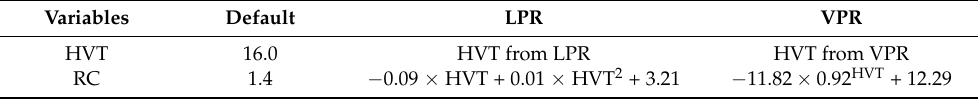
Table 4. HVT and RC functions for Noah-MP